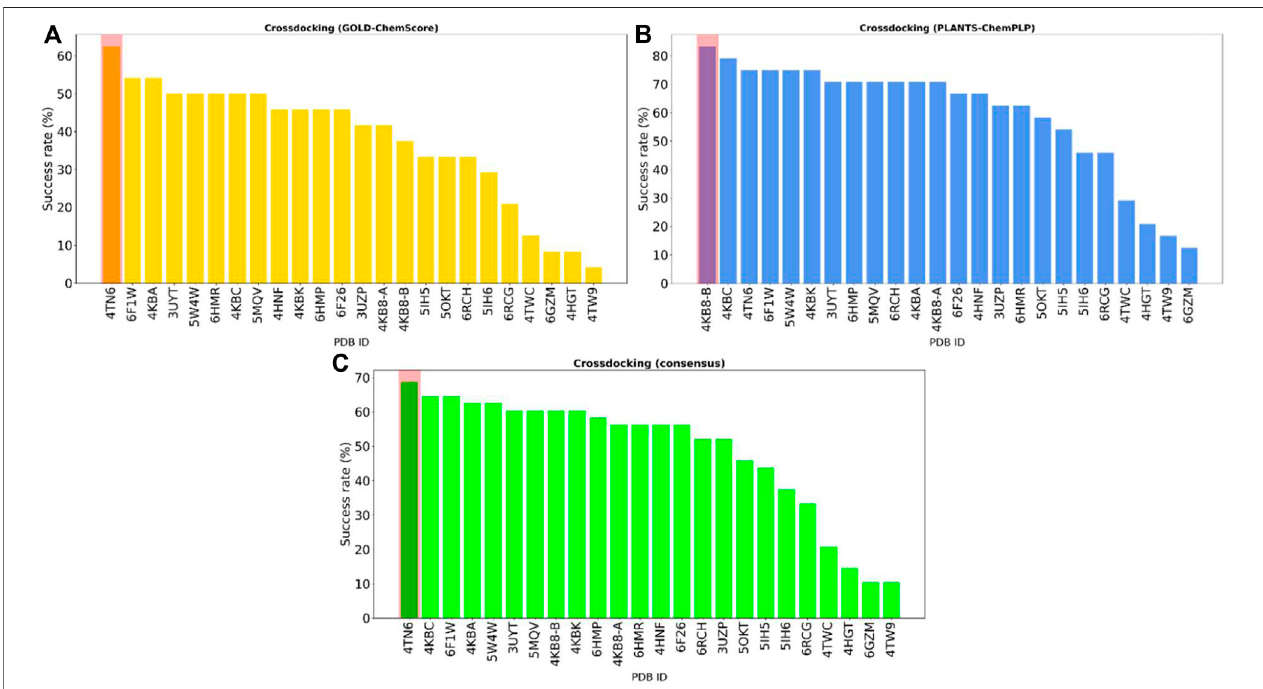
FIGURE 3 | The overall “ success rate ” in reproducing the correct crystallographic binding mode for each of the 24 CK1 δ complexes considered in the study. The “ successrate ” isde fi ned asthepercentage ofsuccessfuldockingrunsfor each protein inthe cross-docking experiment, where asuccessful dockingrunisde fi ned asa docking calculation where the RMSD between the best docking pose and the crystal reference falls below an arbitrarily chosen threshold value of 2 Å. Panel (A) reports the results for the GOLD-Chemscore protocol. Panel (B) reports the results for the PLANTS-PLANTS ChemPLP protocol. Panel (C) encompasses the combined “ success rate ” for each protein, de fi ned as the average between the success rate for each protocol. Protein from the complex 4TN6 was chosen as the most representative CK1 δ structure for successive